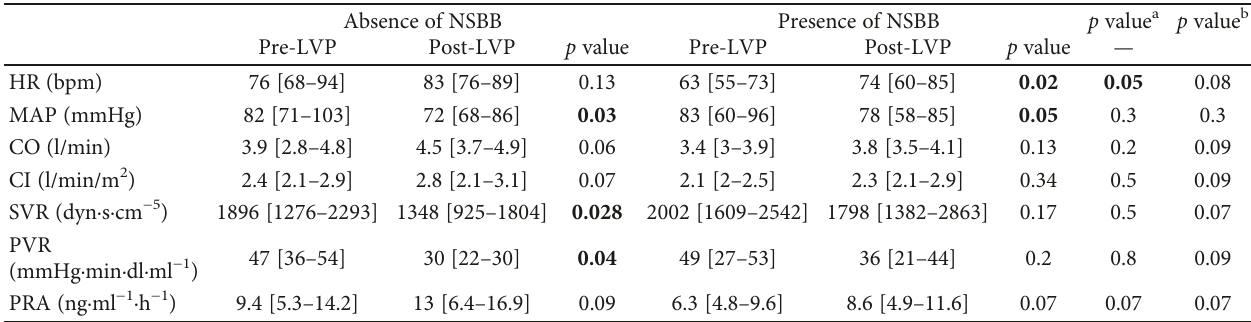
Table 2: Intraindividual changes of hemodynamic parameters before and after LVP, while being on and o ff NSBB. Values are expressed as median (range). HR: heart rate; MAP: mean arterial pressure; CO: cardiac output; CI: cardiac index; SVR: systemic vascular resistance; PVR: peripheral vascular resistance; PRA: plasma renin activity. a Pre-LVP versus pre-LVP with and without NSBB. b Post-LVP versus post-LVP with and without